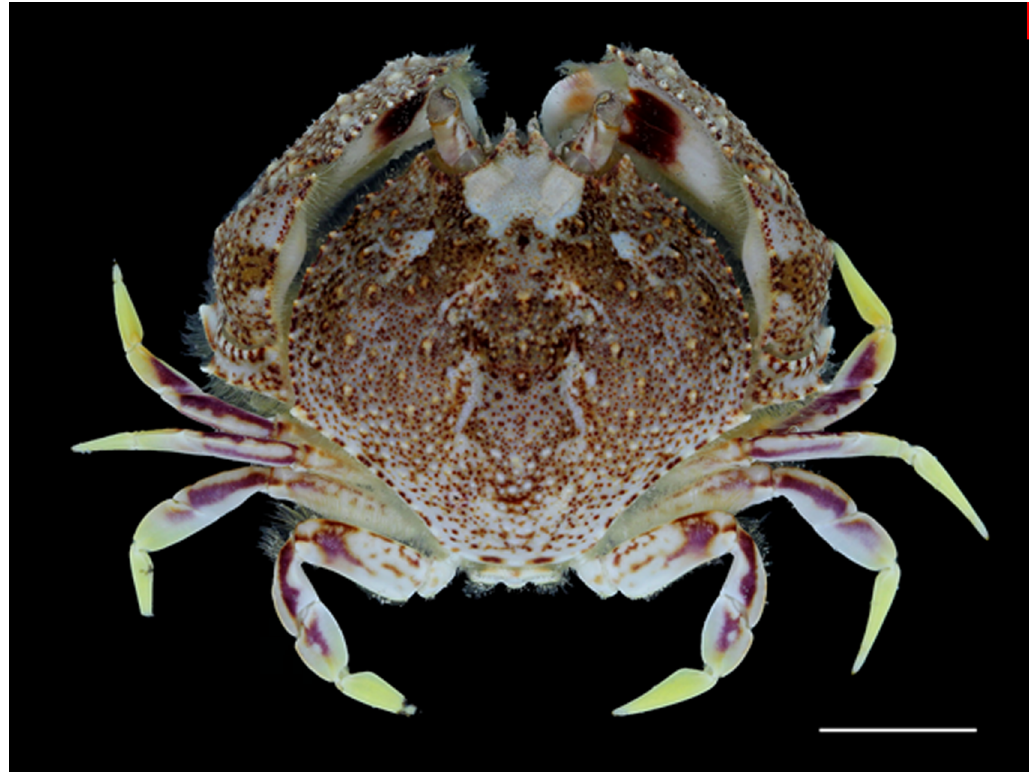
, CC 31.57 mm, CCDB 6417. Scale ♀